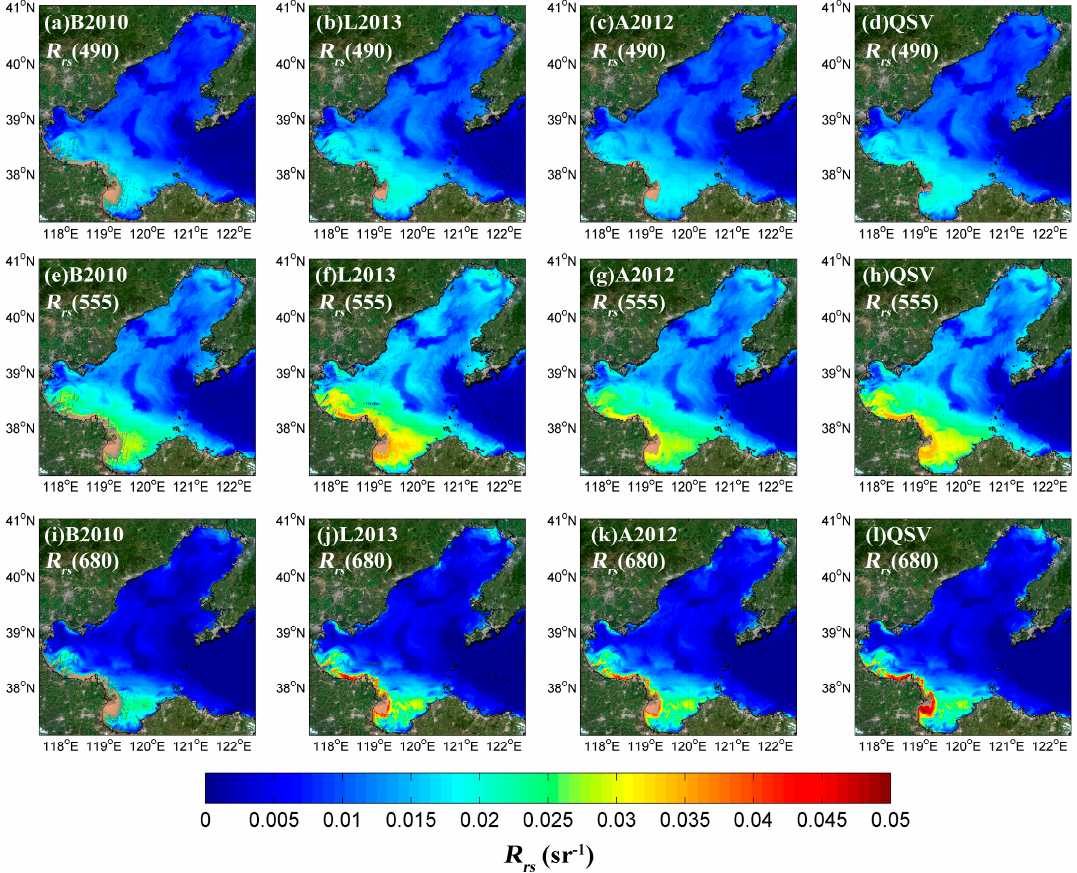
Figure 2. Comparisons of the R rs distributions (unit: sr − 1 ) at ( a – d ) 490, ( e – h ) 555, and ( i – l ) 680 nm bands centered on the Bohai Sea on 26 August 2016 and processed by the B2010, L2013, A2012, and QSV algorithms. The regions in which the algorithms fail to make an AC because of highly turbid waters, or the presence of clouds and land are shown by the composed RGB pictures (B: 490 nm, G: 555 nm, R: 680 nm).